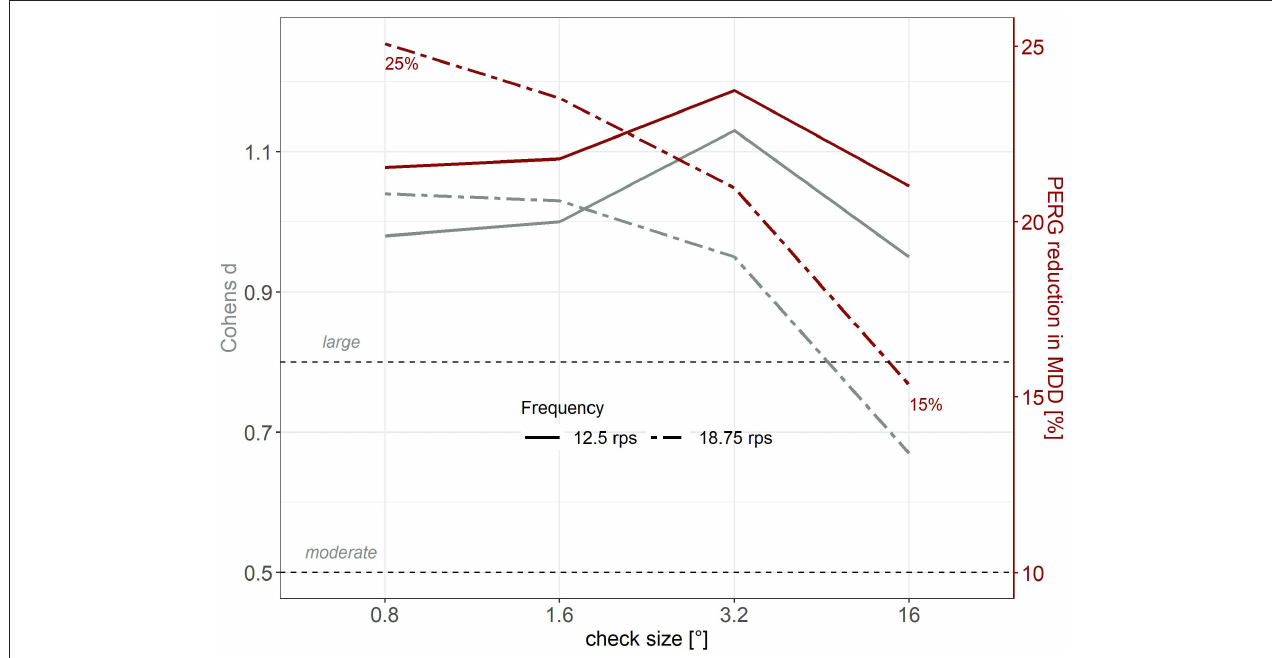
FIGURE 2 | Cohen’s d (gray, left axis) as effect size estimation and mean relative PERG reduction (red, right axis, %) in MDD patients compared to healthy controls as a function of check size. Continuous lines depict 12.5 rps, dashed lines represent 18.75 rps.